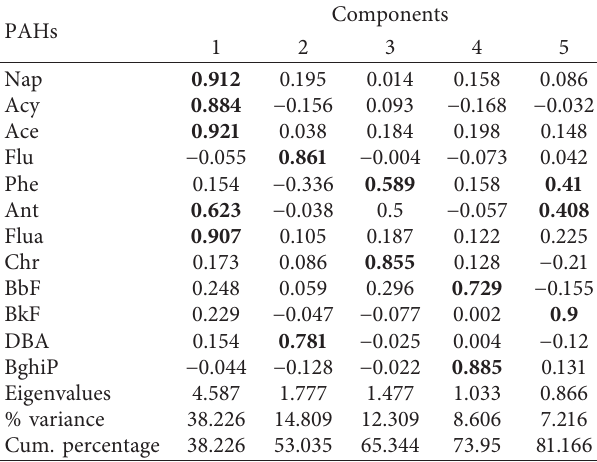
Table 2: Rotated component matrix of studied PAHs in the Yellow River (Wuhai